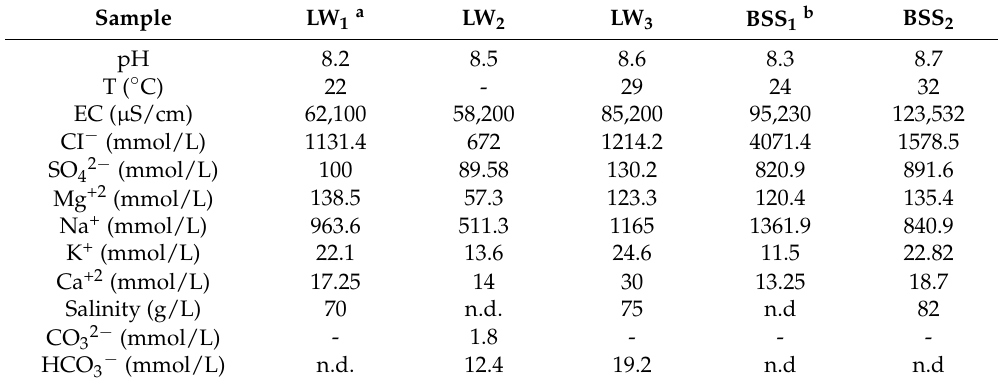
Figure 1. Location of the study area and sampling points in Lake Acıgöl, SW Turkey. Table 1. Physico-chemical characteristics of the lake and the saltern ponds water overlying the sampled